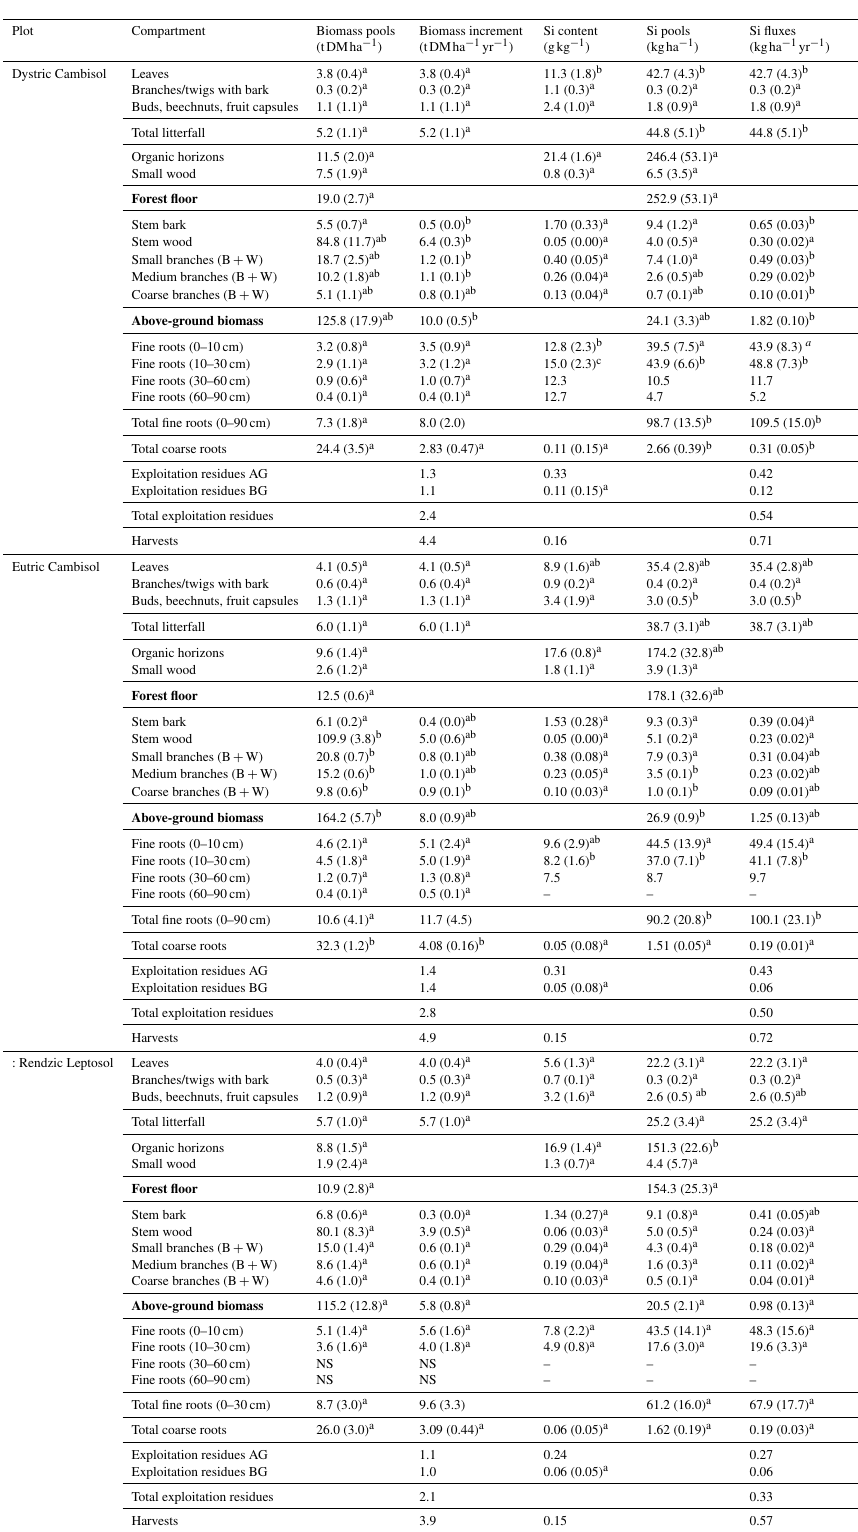
Table 2. Mean Si contents, pools and fluxes in the biomass of the three soils at the Montiers site. SD values are given in brackets. Values with different letters are significantly different according to a Kruskal–Wallis test at the threshold P value level of 0.05 (soil effect; DC, EC and RL). B + W stands for bark and